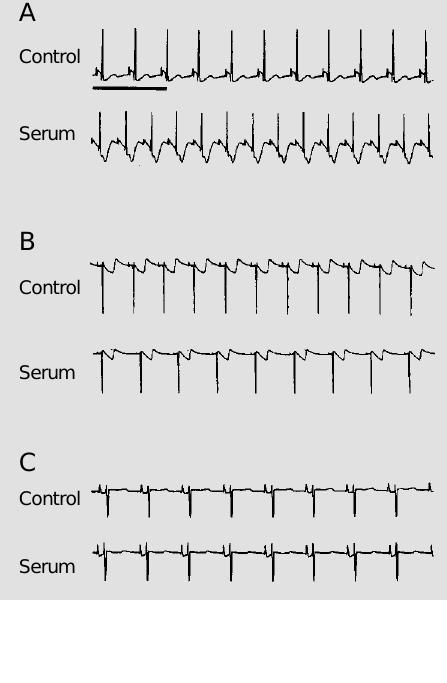
Figure 3 - Muscarinic and beta- adrenergic-like effects of sera from chronic chagasic patients. A , Control and washout traces represent ECG recorded during Tyrode perfusion, and the middle trace, labeled serum, was obtained in the presence of a serum that induced a decrease in sinus rate. B , Control and washout, obtained in the pres- ence of 1 µM atropine; S/Atr, obtained with the same serum as used in A, now in the pres- ence of 1 µM atropine. In this case the serum did not induce bradycardia. C , Control and washout, perfusion with Tyrode; serum, in the presence of a se- rum inducing an increase in heart rate. D , Control and wash- out in the presence of 1 µM pro- pranolol; S/Prop, in the presence of propranolol, the same serum as used in C did not induce ta- chycardia. Horizontal bar indi- cates 1